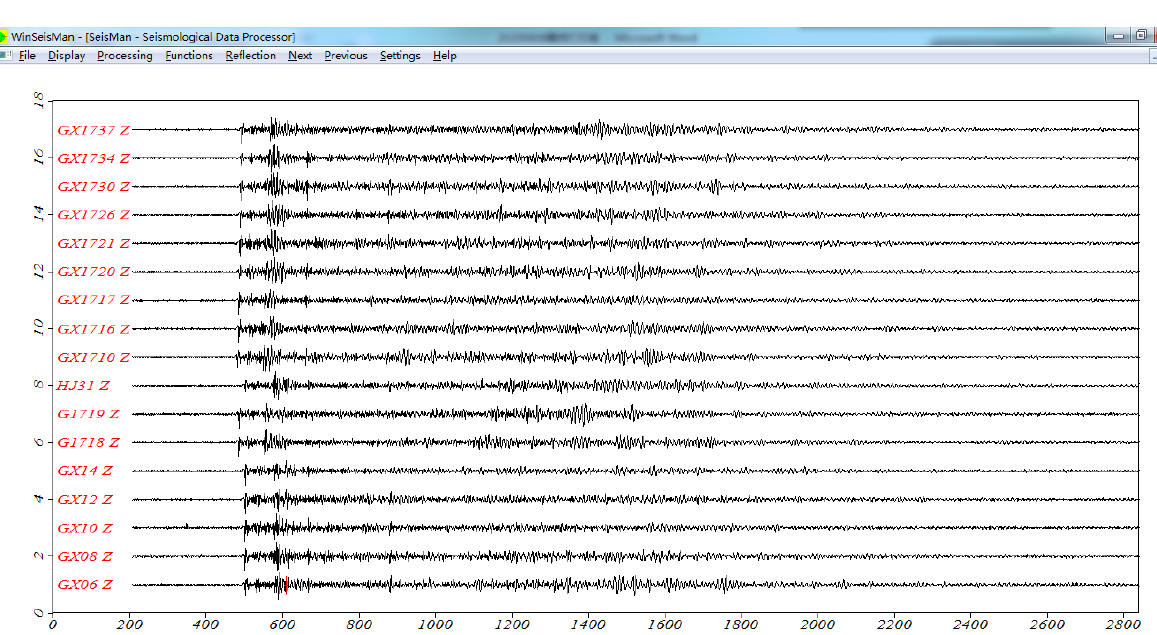
Figure 7. Seismic data after removal of bad traces and filtering.